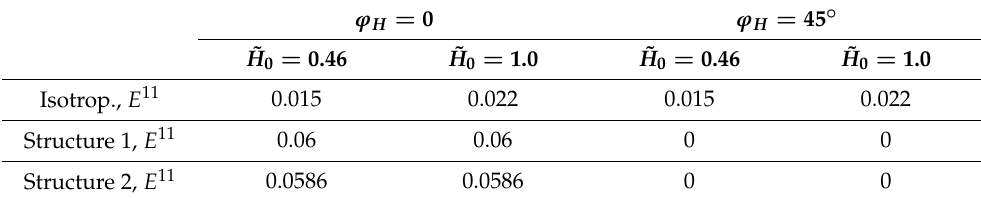
Table 3. The results of the performed deformation analysis ϕ H = 0 ϕ H = 45 ◦ ˜ H 0 =